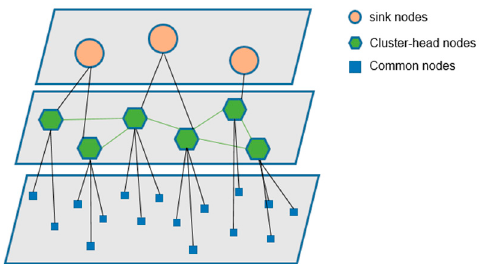
Figure 1. Hierarchical topology of industrial wireless sensor networks.